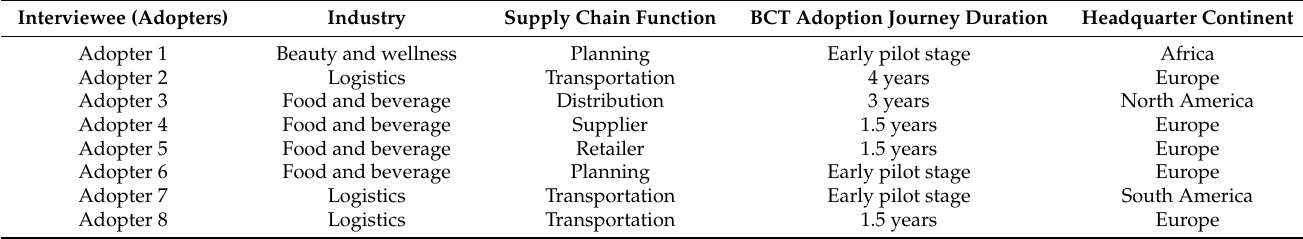
Figure 1. Research process flow of the study. Table 1. Characterization of industry adopters’ representatives.